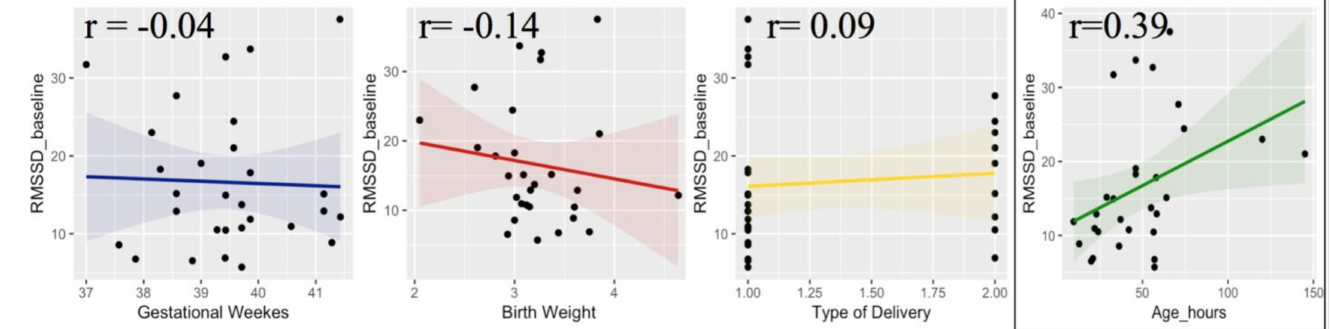
Figure 5. Correlation between RMSSD score during resting baseline and neonatal information, including gestational weeks (blue), birth weight (red), type of delivery (yellow) and postnatal age in hours (green).